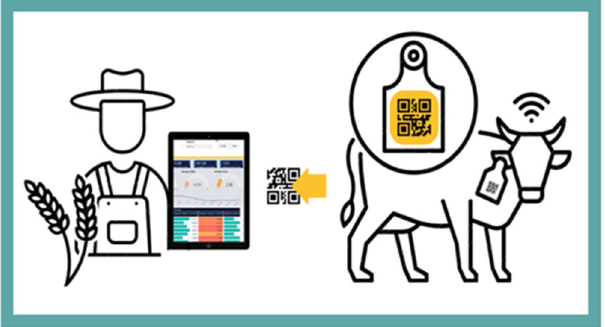
Figure 5. Personal identification by QR code.